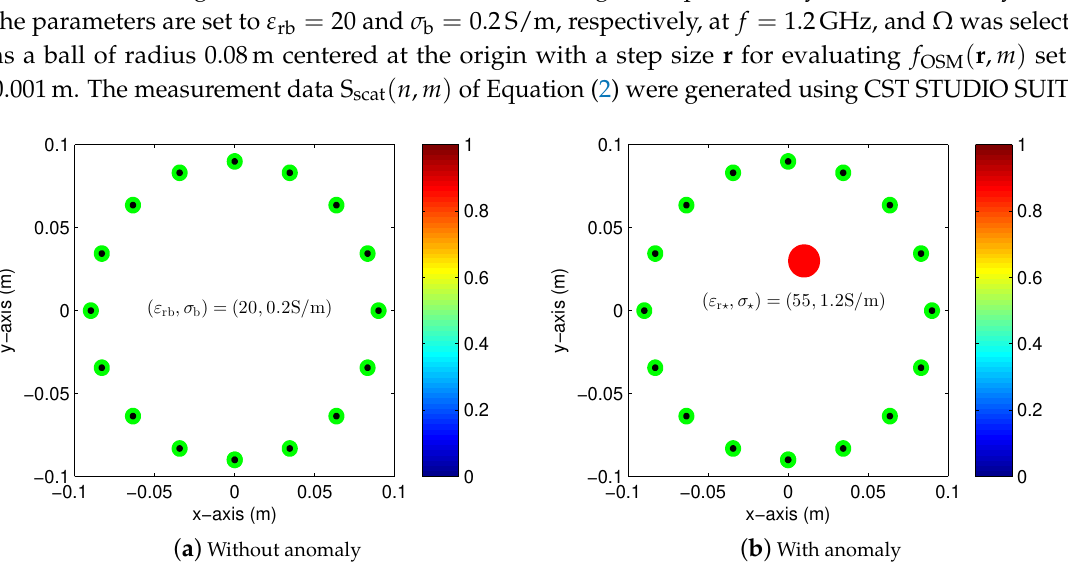
Figure 1. Illustration of simulation